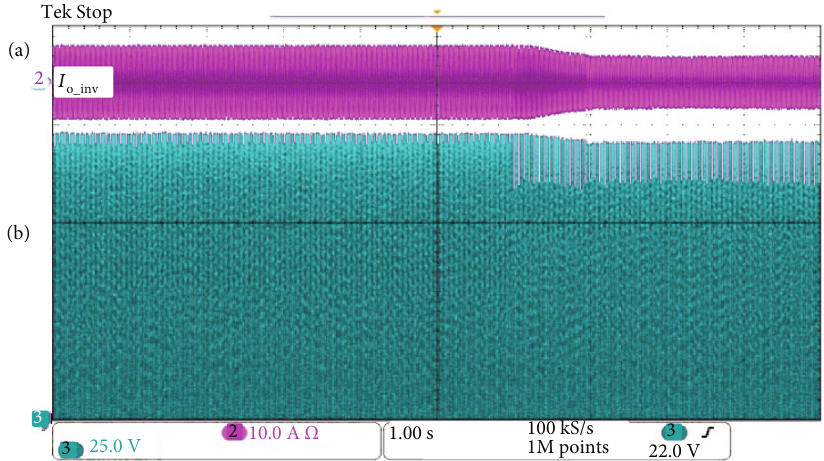
Figure 12: Transition from traditional MPPT and the proposed APC: (a) current in residence 11 ( I 11 ( V , 25V/div). Time 11